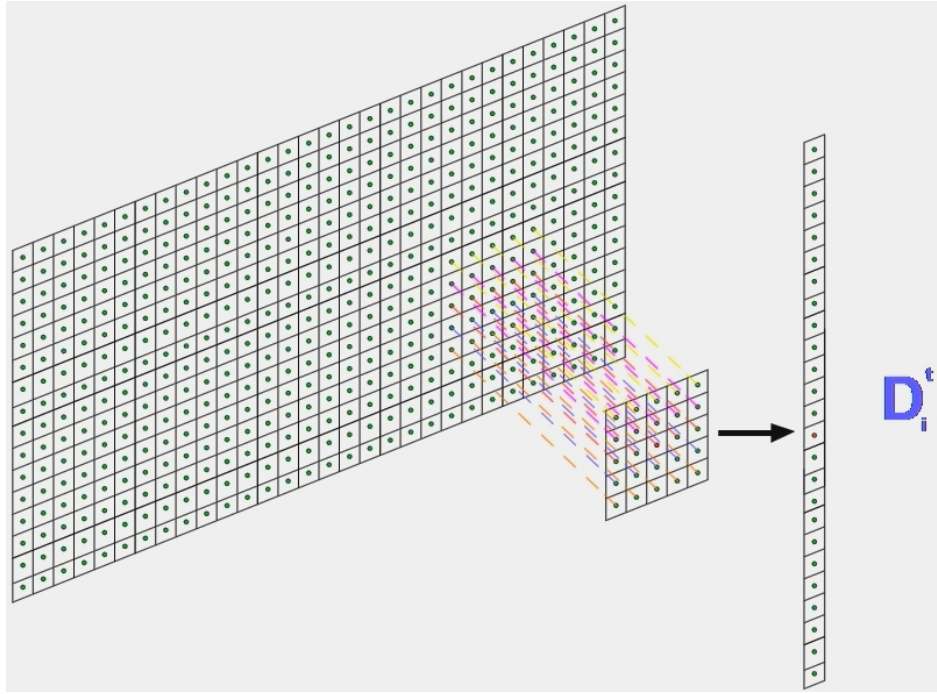
Figure 3. Creating density input